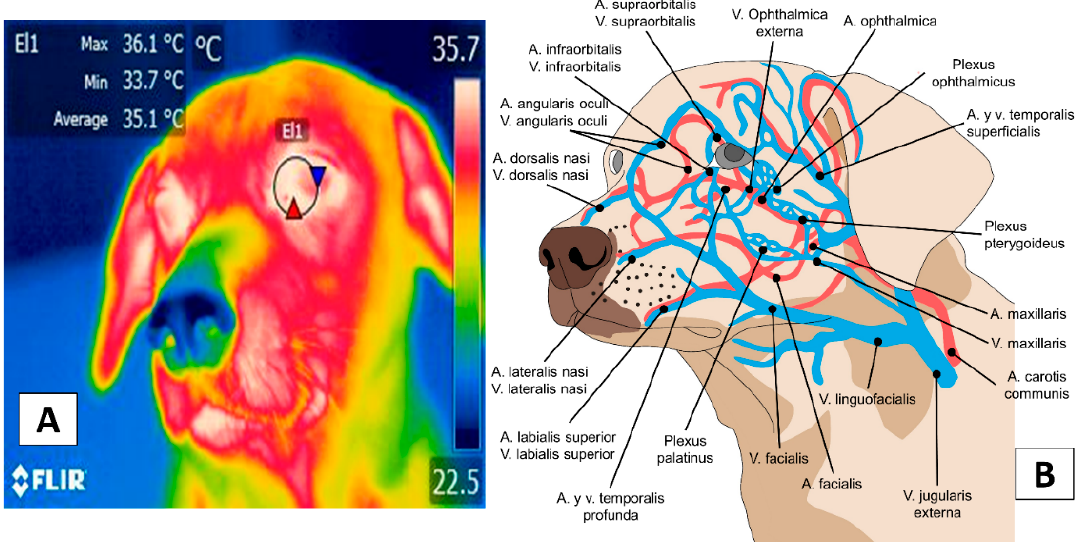
Figure 1. The thermal window of the lacrimal caruncle (El1). This window considers the region of the medial canthus of the upper and lower eyelids ( A ), which receive circulation from the supraorbital and infraorbital arteries ( B ). The latter holds sympathetic innervation from the infraorbital branch of the facial nerve, responsible for the autonomic hemodynamic activity of this region. Thermal images obtained using a FLIR thermal camera (Wilsonville, Oregon, U.S.).